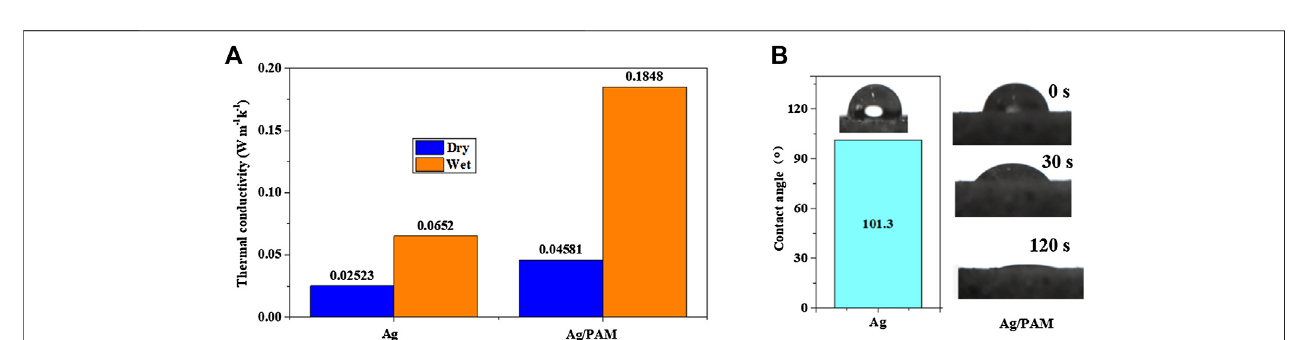
FIGURE 2 | (A) Thermal conductivity and (B) water contact angles of Ag-based materials.